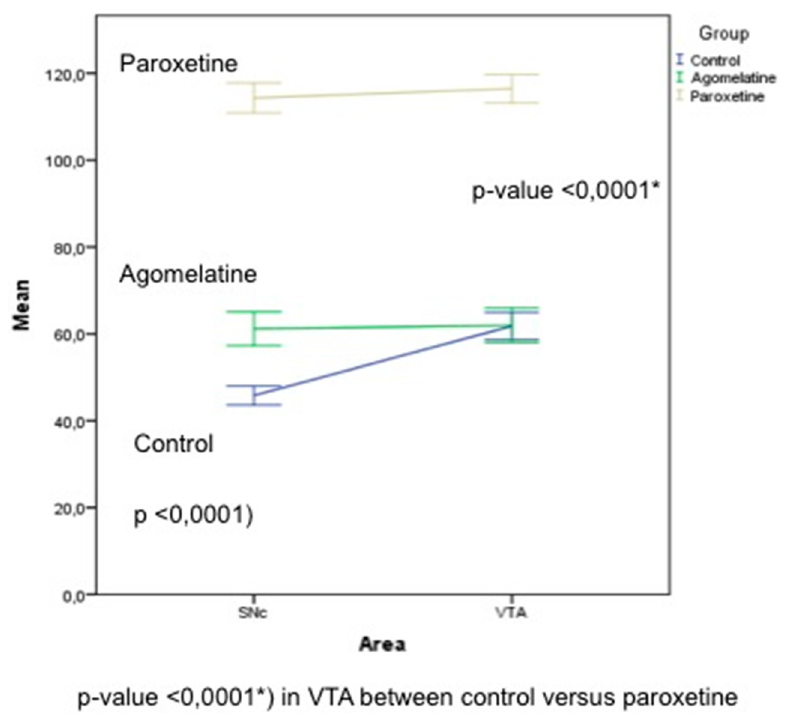
Figure 7. Pixel intensity was determined using open source software ImageJ. There are significant differences between all groups in the SNc, but no statistical difference between the control group and rats treated with agomelatine in the VTA.